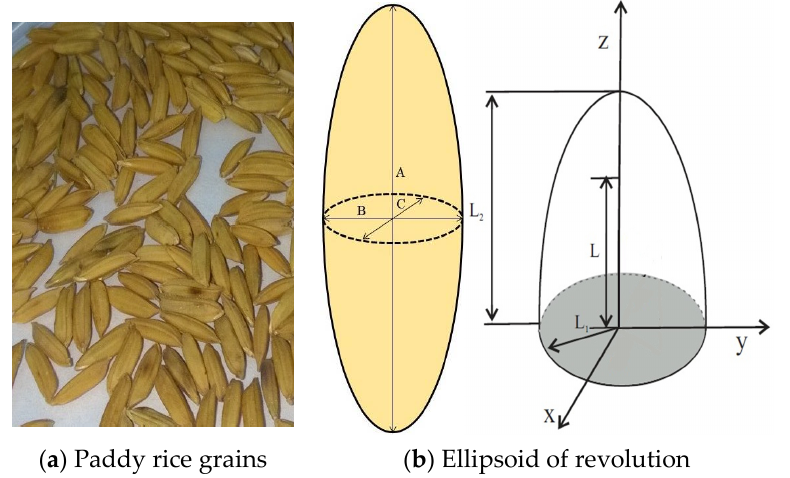
Figure 2. Comparison of the shape of the paddy rice grain ( a ) with the revolution ellipsoid ( b ).